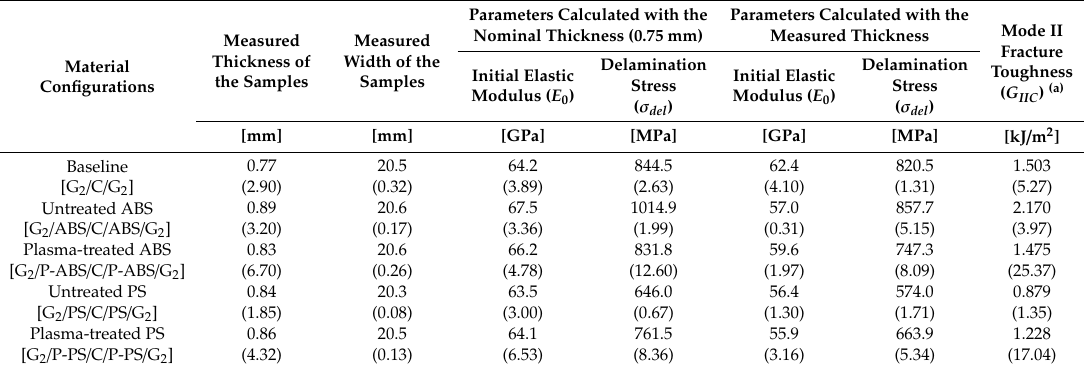
Table 6. Results of the tensile tests on the hybrid composite material configurations (the CV in % is in brackets below the mean values).